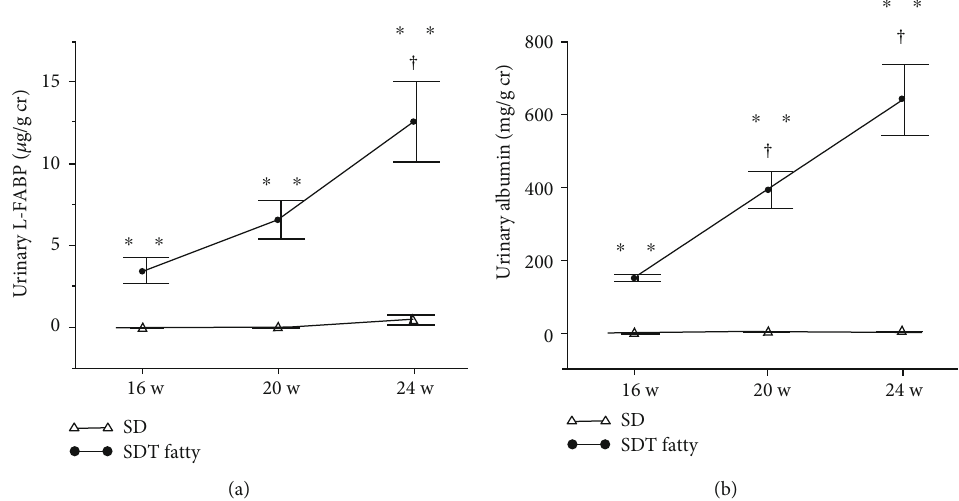
Figure 1: Changes in urinary parameters of SD and SDT fatty rats. Urinary L-FABP levels at 16, 20, and 24weeks of age (a) and urinary albumin levels at 16, 20, and 24weeks of age (b). Values are presented as the mean ± standard errorof the mean (SEM). ∗∗ p < 0 : 01 vs. SD rats at the same age; † p < 0 : 05 vs. SDT fatty rats at 16 weeks of